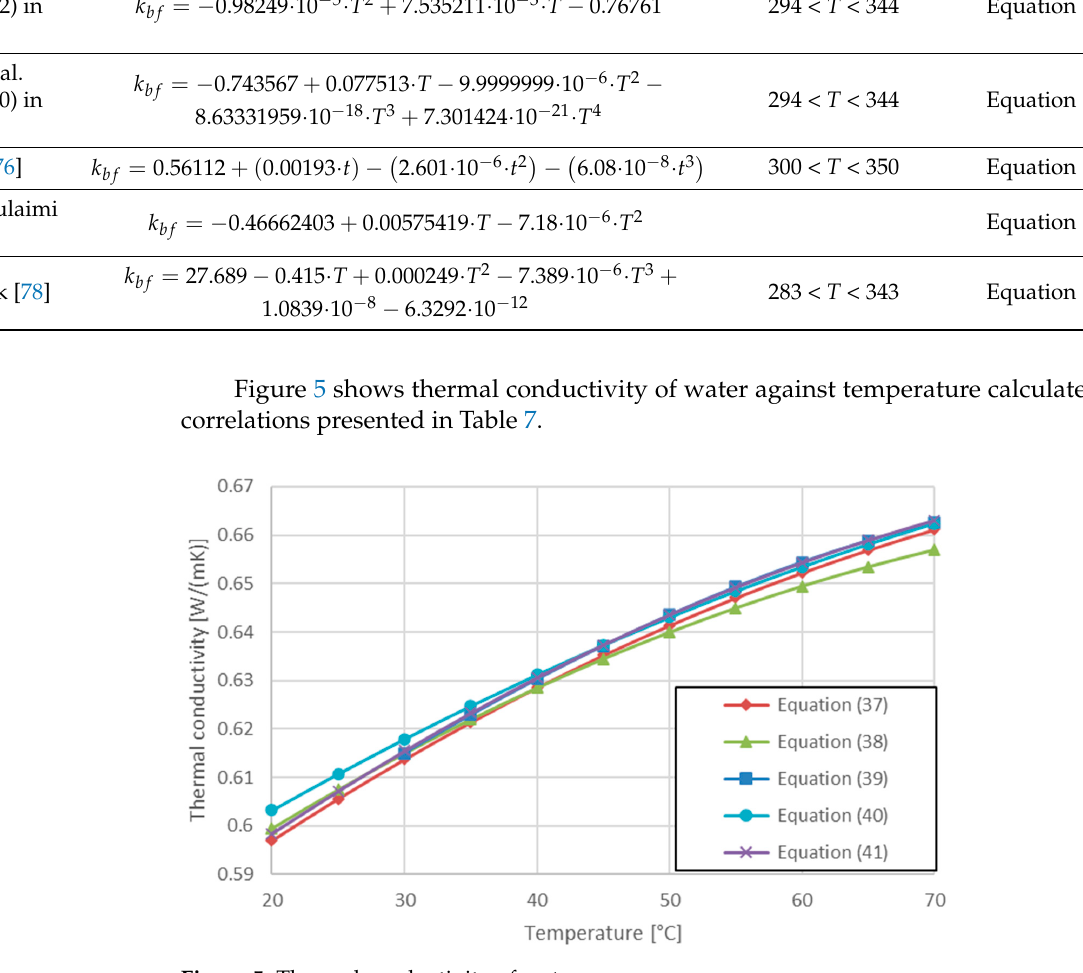
Figure 6. Thermal conductivity of water-Al 2 O 3 nanofluids.